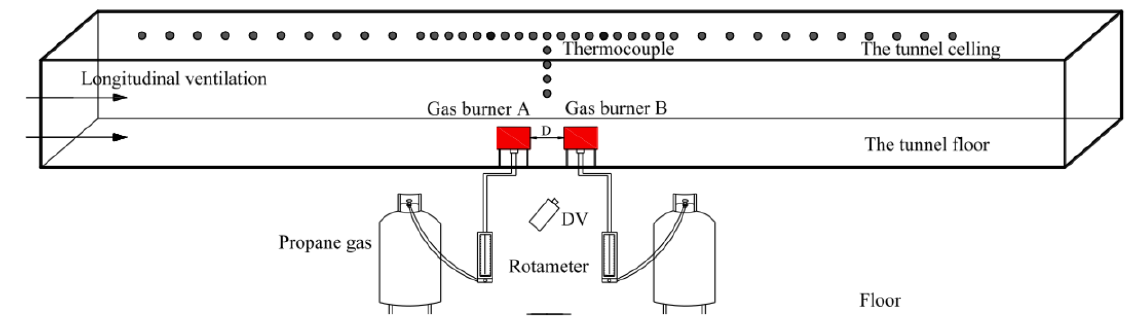
Figure 10. Experimental setup [56].